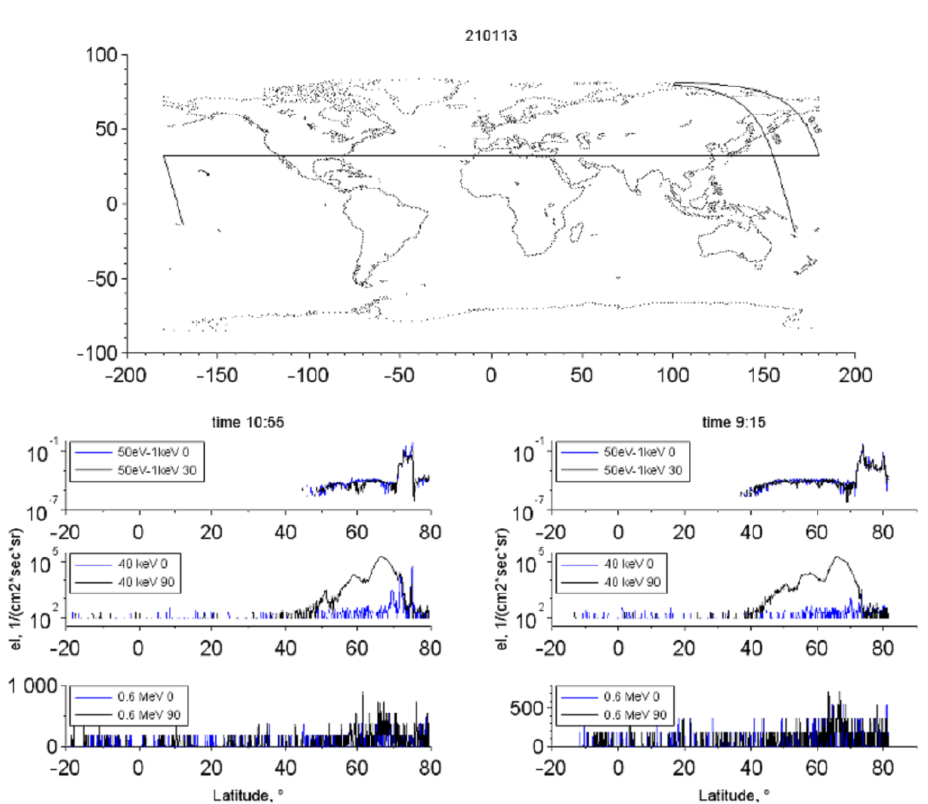
Fig.5. Electron fluxes recorded on the Metop 1 satellite during lidar observations on January 13,